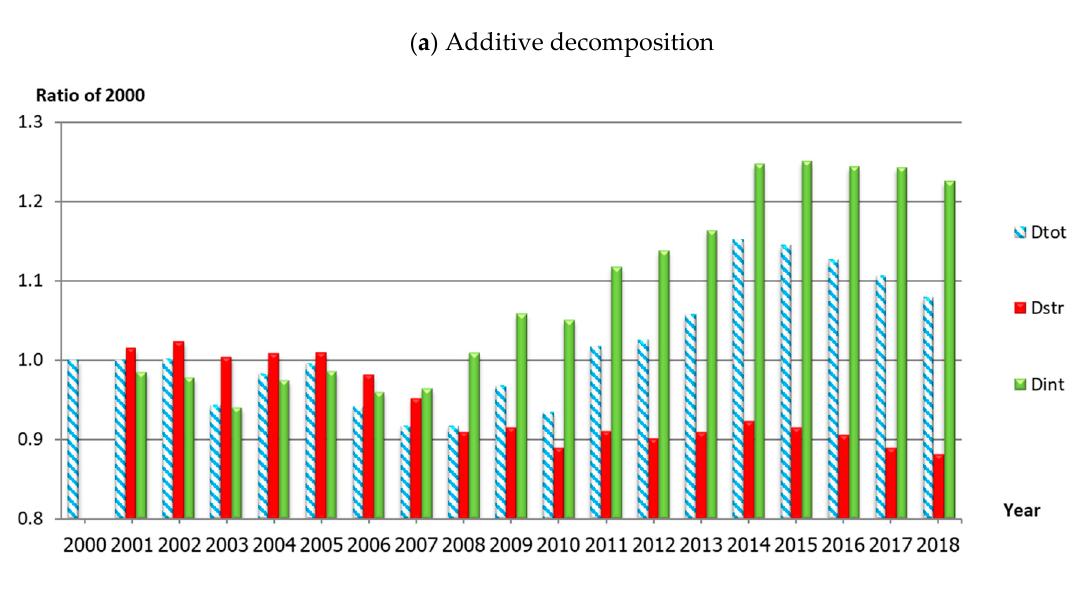
Figure 2. Decomposition of CO 2 emission intensity of the manufacturing sector, 2000–2018: ( a ) Additive decomposition; ( b ) Multiplicative decomposition.